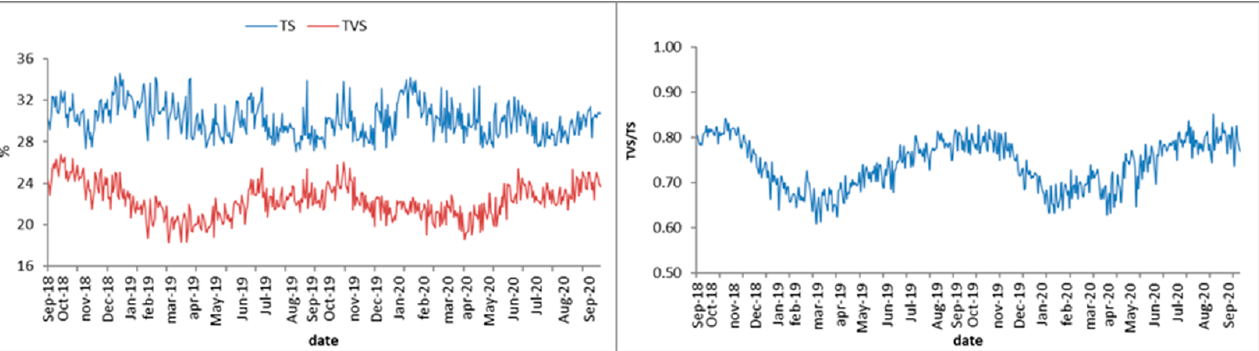
Figure 3. Total solids—TS (blue line) and total volatile solids—TVS (red line) variation and TVS/TS ratio variation of pretreated SC ‐ OFMSW from September 2018 to September 2020.